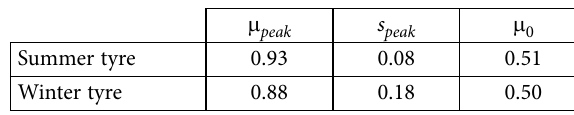
Table 4. Differences in slip referring to m peak adhesion coefficient